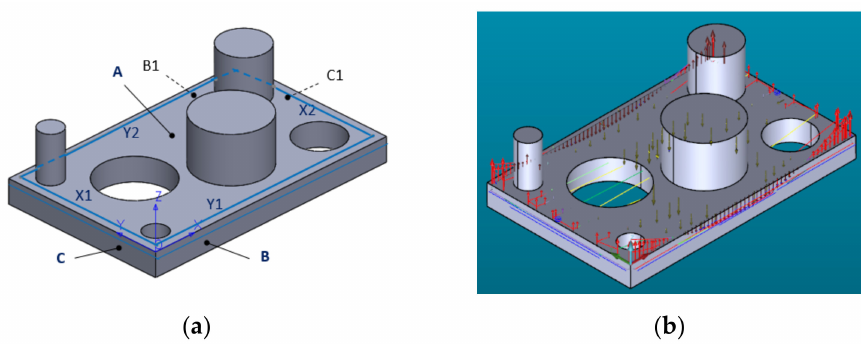
Figure 3. Printed part measurement: ( a ) Definition of the part measurement features: A, B, C, B1, C1—flat surfaces; X1, X2, Y1, Y2—linear contours; ( b ) Probing point’s patterns and deviations direction.